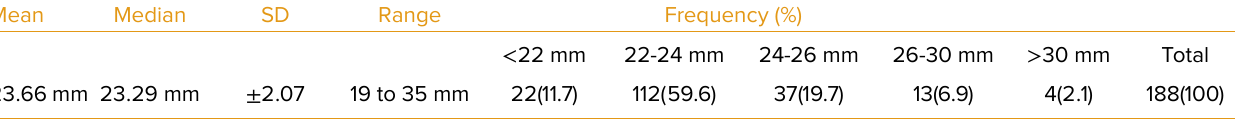
SD, standard deviation Table 2. Prediction and absolute prediction error and percentage of patients within the predicted refraction for each formula Formula PE AE % Within Predicted Mean SD Median Range Mean SD SRK/T Hoffer Q Holladay 1